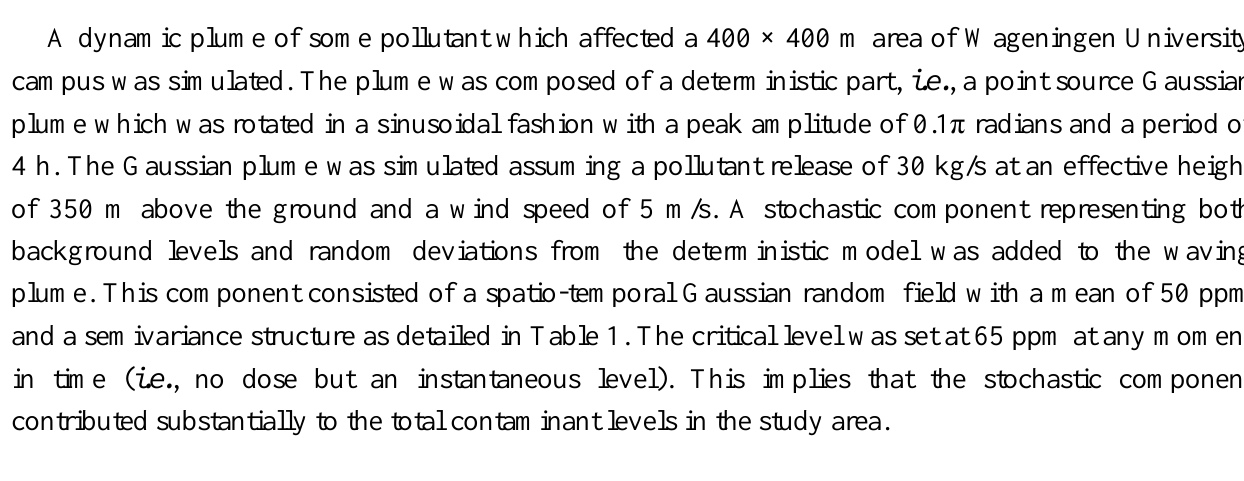
Table 1. Semivariance structure of the Gaussian random field added to the deterministic